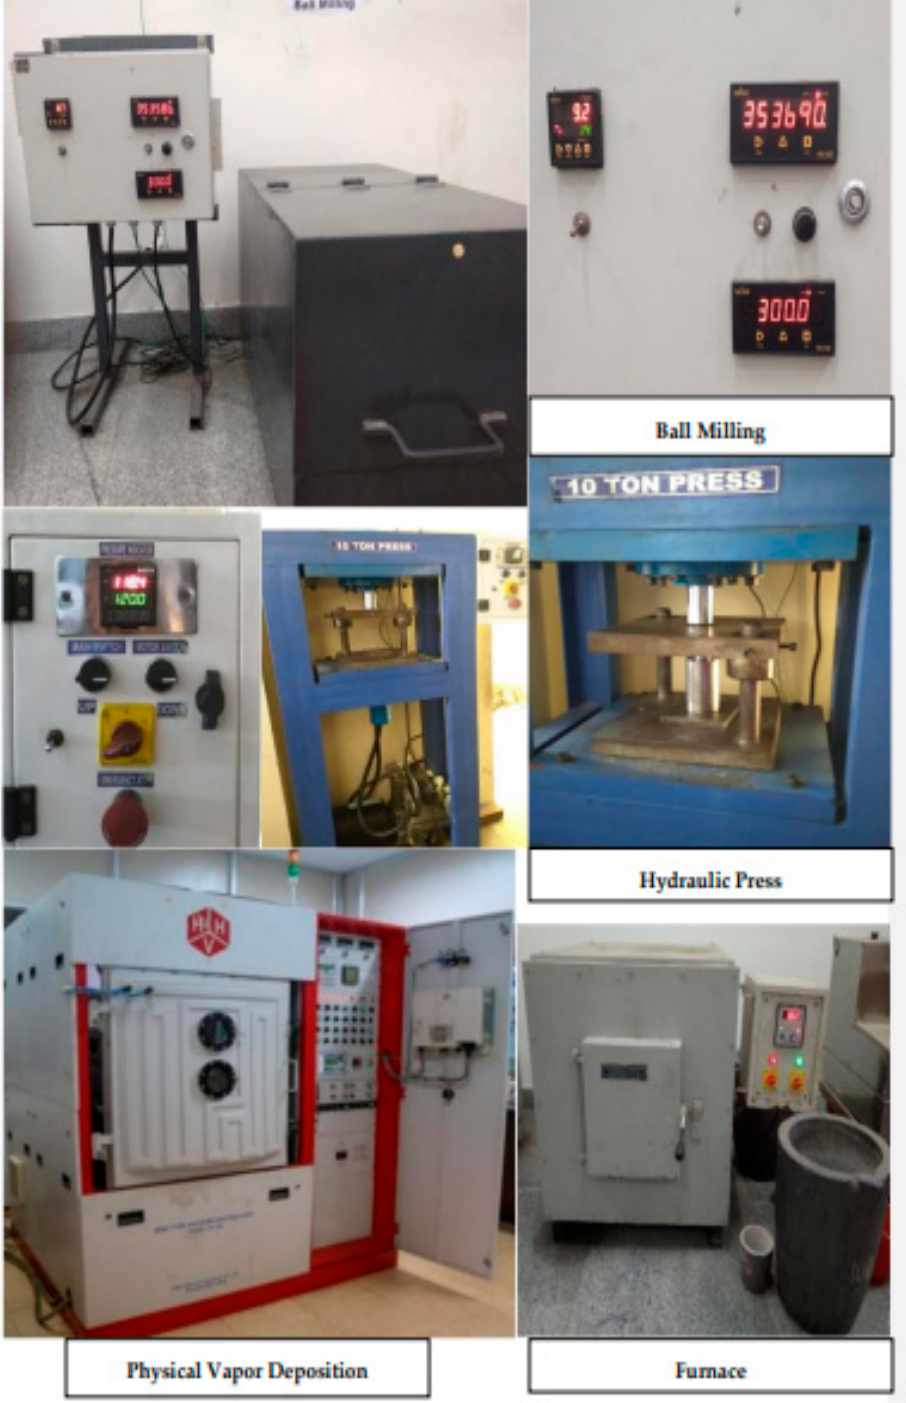
Figure 5. Process equipment in processing of the Al-SiC-TiC metal matrix composite.